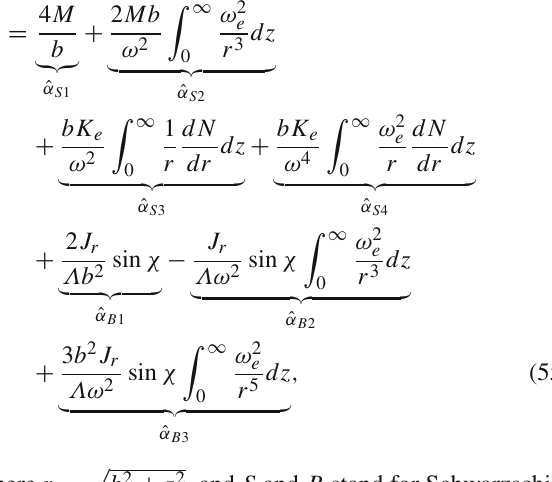
Fig. 3 Plot of ˆ α b vs. b / 2 M in the presence of uniform plasma for the slowly rotating (dot-dashed line) and ˆ α bS (dashed line). In the figure it is also plotted the Schwarzschild case in vacuum (continuous line). We used Λ = 0 . 5, J r / M 2 = 0 . 25, sin χ = 1, and ω 2 e /ω 2 = 0 . 5